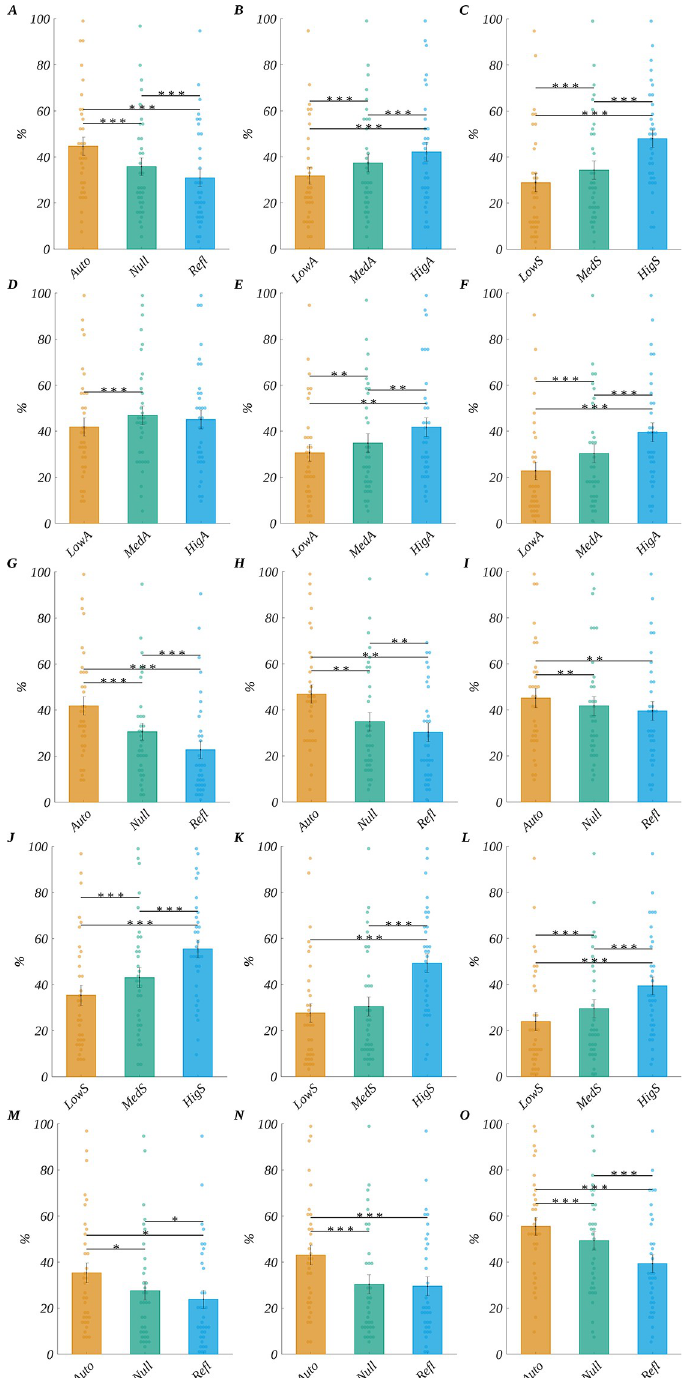
Fig 3. Decision results. The main effects for emotional ratings: (A) origin, (B) arousal, (C) subjective significance. Effects of interactions for emotional ratings: interaction between origin and arousal for words of origin: (D) automatic, (E) Null, (F) Reflective; interaction between origin and arousal for words of arousal level: (G) low, (H) medium, (I) high; interaction between origin and subjective significance for words of origin: (J) automatic, (K) Null, (L) Reflective; and interaction between origin and subjective significance for words of subjective significance level: (M) low, (N) medium, (O) high. Bars represent the mean value, error bars SEM, individual dots mark the average ER of an individual subject in the given condition, black horizontal lines indicate pairs of conditions with significantly different means ( � p < 0.05, �� p < 0.01, ��� p < .001).